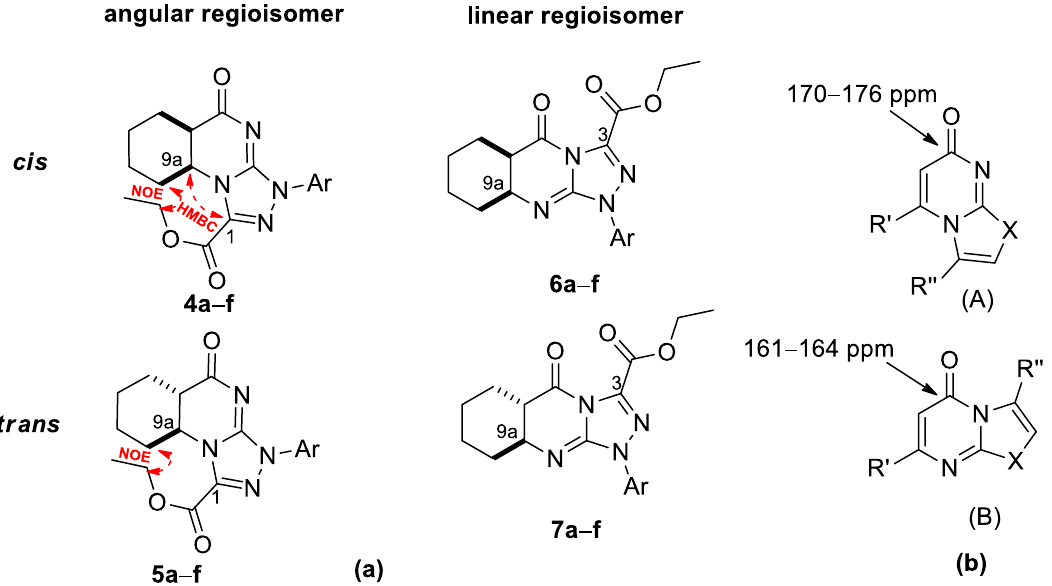
Figure 1. ( a ) Heteronuclear multiple bond correlation (HMBC) and neighboring Overhauser effect (NOE) mutual correlations in angular regioisomers, and the lack of a similar correlation in their linear counterparts. ( b ) 13 C-NMR data used for assigning the stereochemistry of the products.